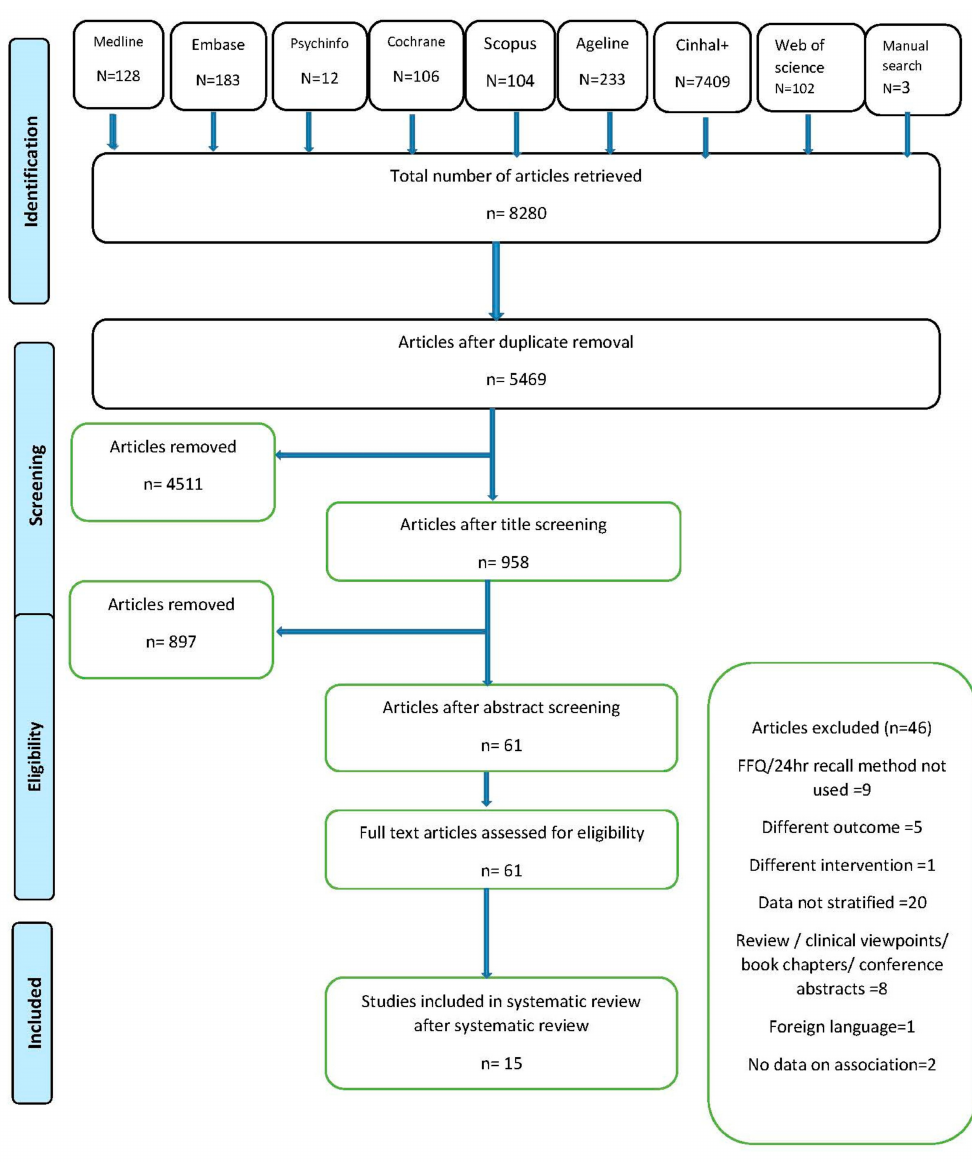
Figure 1. Preferred Reporting Items for Systematic Reviews and Meta-Analyses (PRISMA) flow diagram of identification, screening and selection process for included